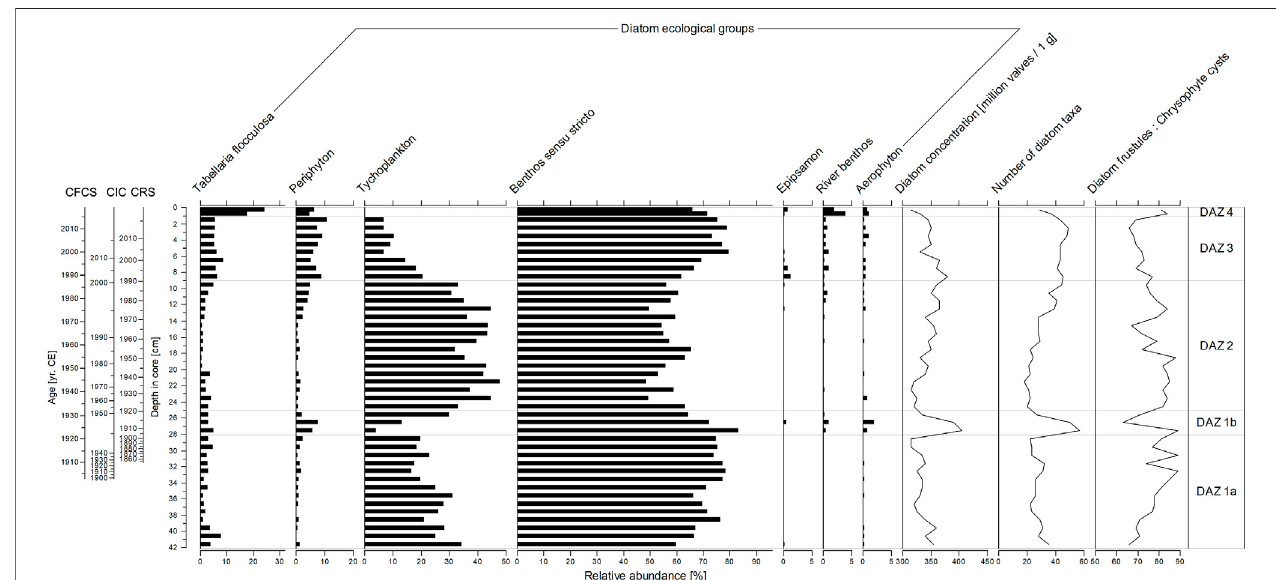
FIGURE4| Summarydiatomstratigraphy diagram(coreSUZ1),showingtheproportionofecologicalgroups,diatomvalveconcentrationandtaxonomicdiversity, and the D to C ratio. Tabellaria fl occulosa is listed alone as it can be present in both tychoplankton and periphyton categories. For information about taxa included into particular ecological groups see the Supplementary Material ( Supplementary Figure S7